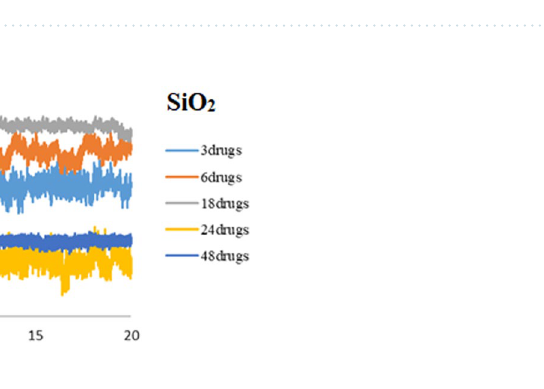
Figure 14. RMSD values of 3TC-PEG complex for 3, 6, 18, 24, and 48 drug molecules during 20 ns simulation time.